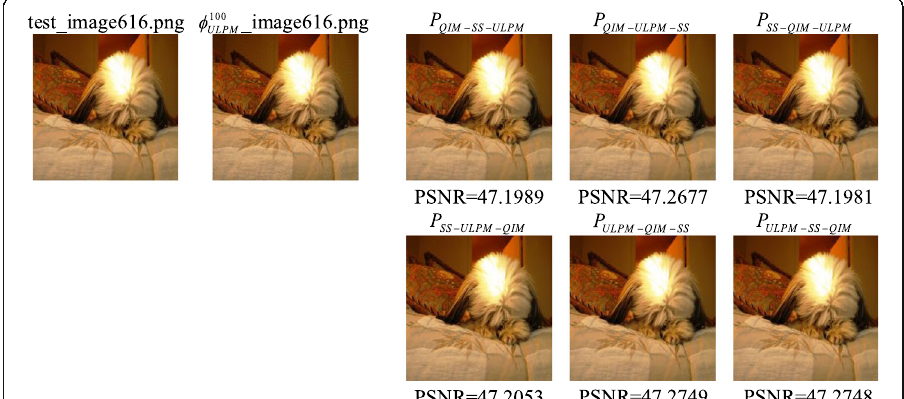
Fig. 6 The “ ϕ 100 _image616.png ” and different processed ULPM